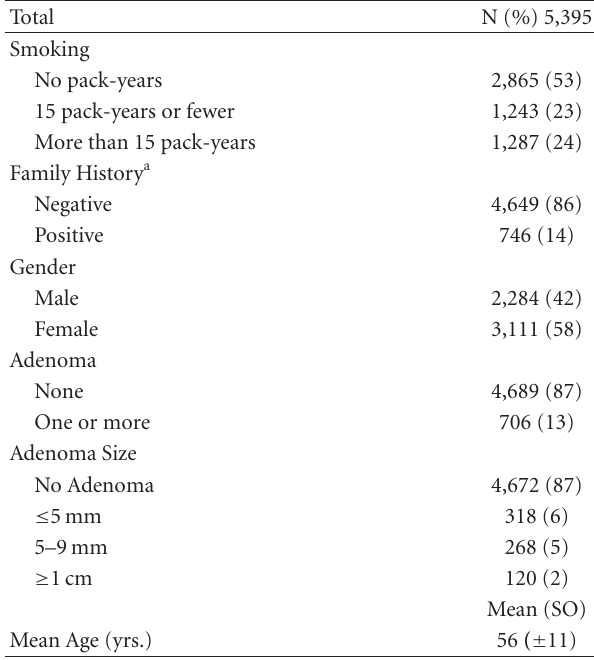
Table 1: Characteristics of the study population undergoing screen- ing colonoscopy in the New Hampshire Colonoscopy Registry from 2004–2006.